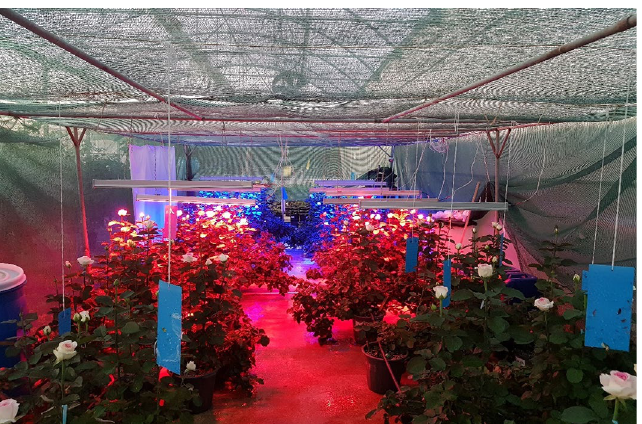
Figure 1. Treatment of Dolce Vita roses with blue and red